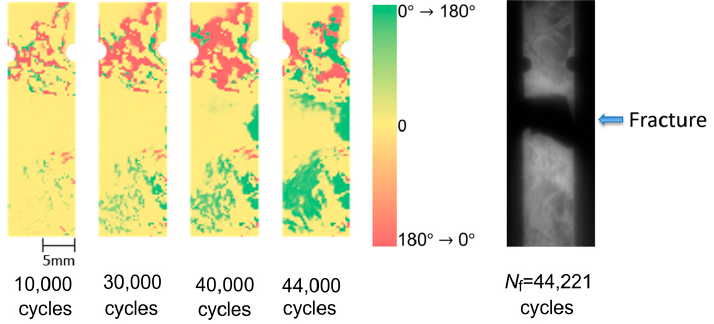
Figure 9. Results of thermoelastic phase damage analysis (TPDA) indicating early fatigue damage evolution ( σ max = 180 MPa, f = 7 Hz).